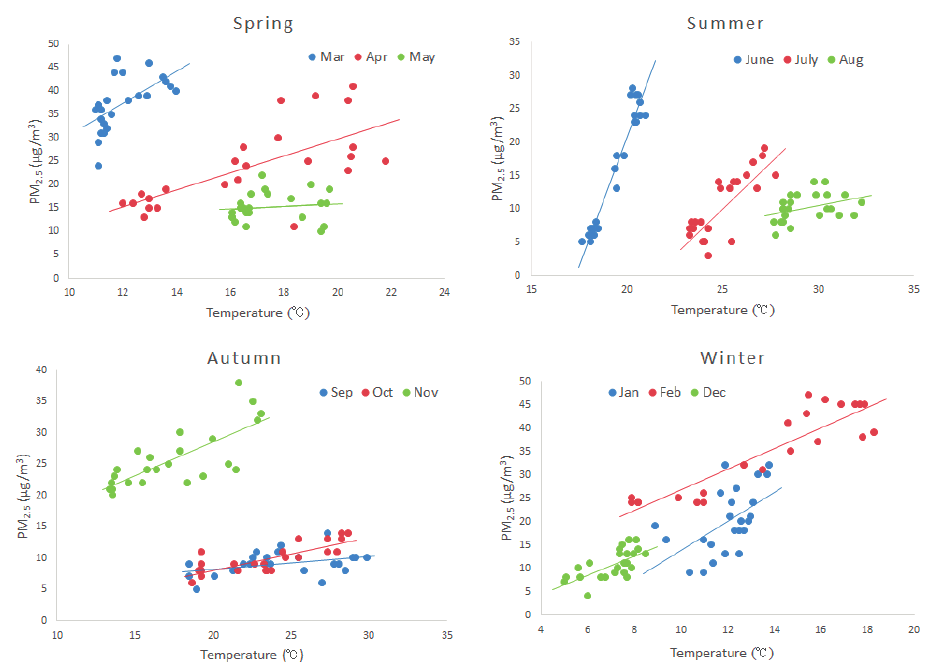
Figure 4. The relationship between PM 2.5 and temperature over four seasons. The straight lines are the unary linear regression.